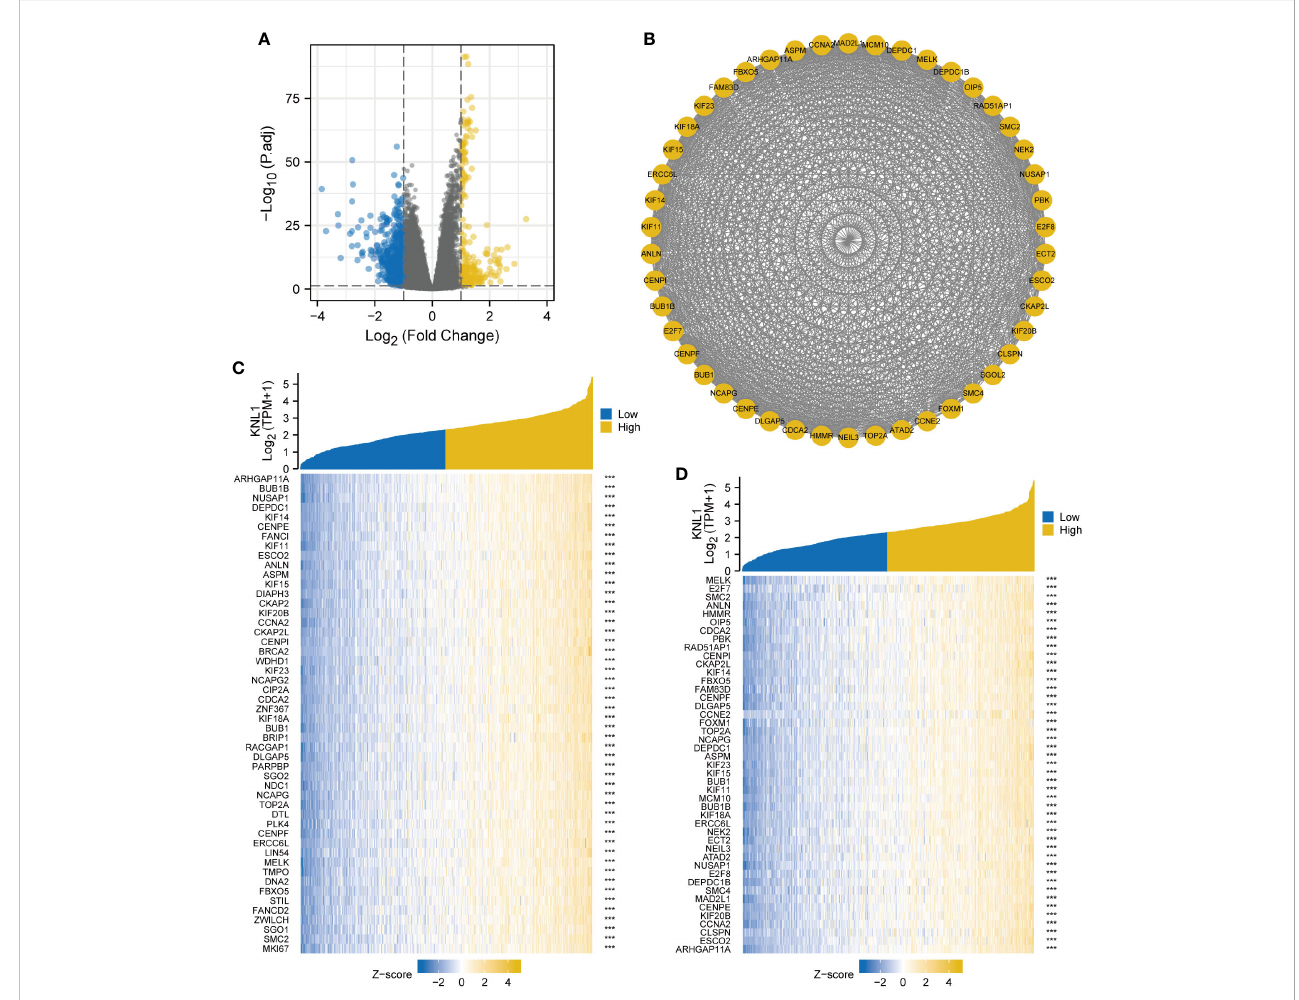
FIGURE 3 Single gene differential analysis and correlation analysis of KNL1. (A) Volcano map for single gene differential analysis of KNL1. (B) Protein interaction network diagram (PPI) of the HUB genes. (C) Heatmap of coexpression of the top 50 most correlated genes with KNL1 in single gene correlation analysis. (D) Heatmap of single gene coexpression of the HUB genes and